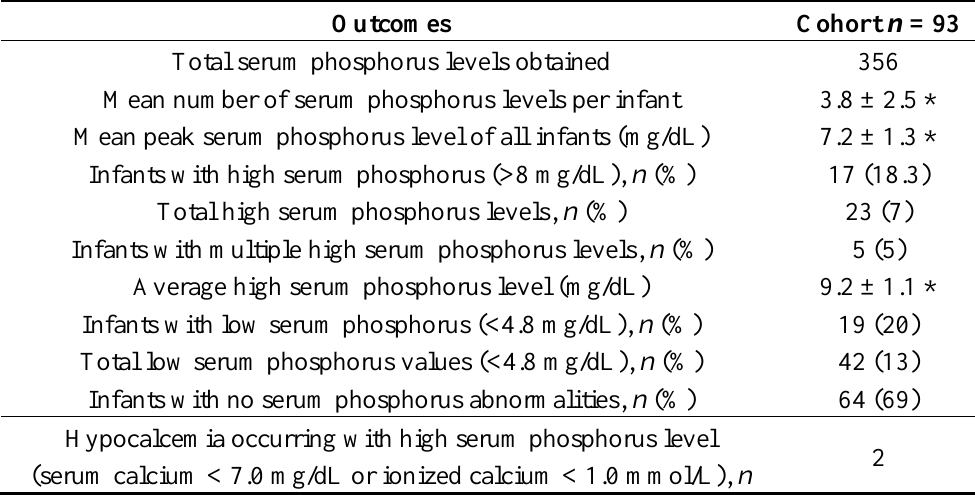
Table 2. Outcomes.